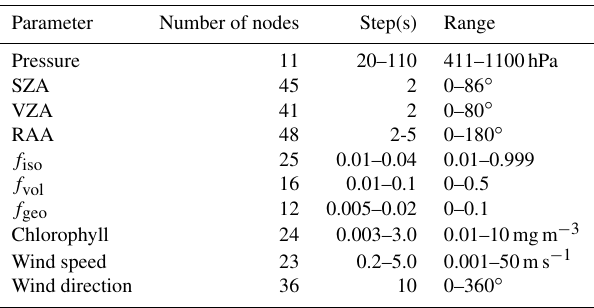
Table B1. LUT structures for input